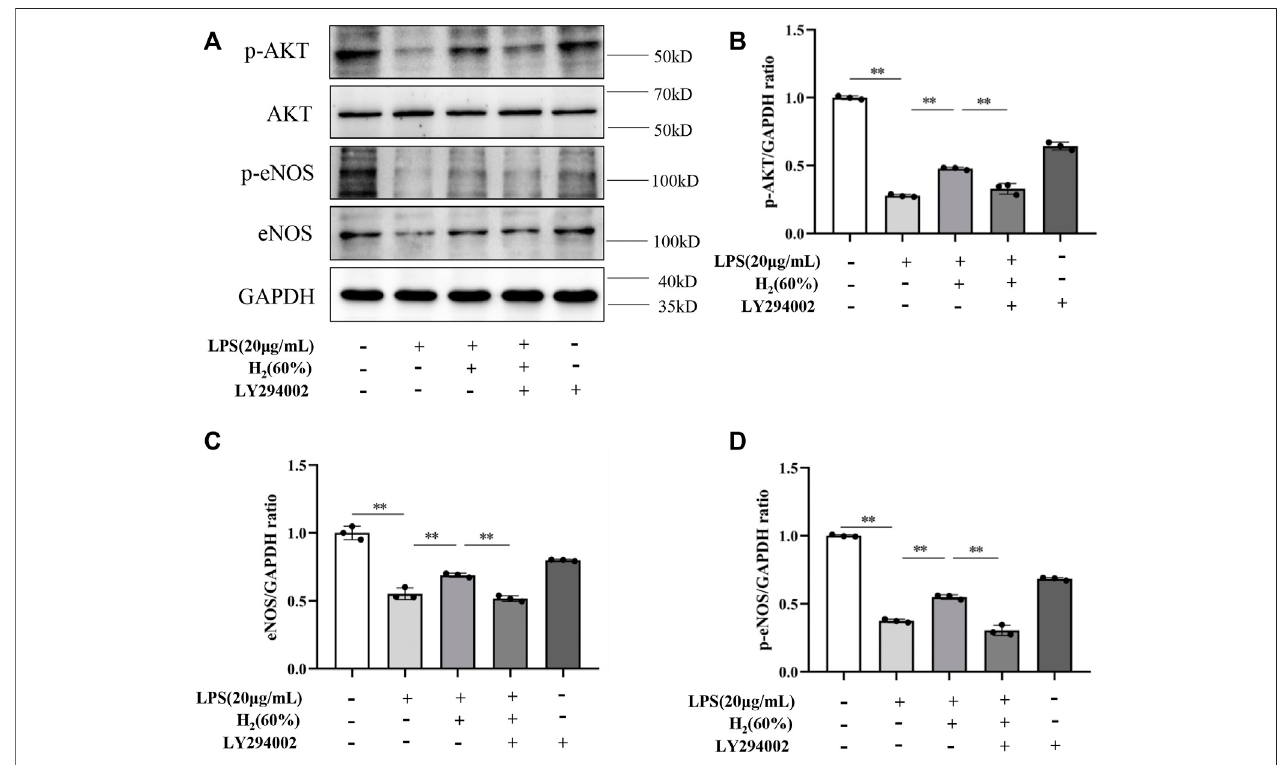
FIGURE 6 | (A) Representative western blot images. LY294002 inhibited the increase of p-AKT (B) , eNOS (C) and p-eNOS (D) expression induced by H 2 (60%). CellsweretreatedwithLPS(20 μ